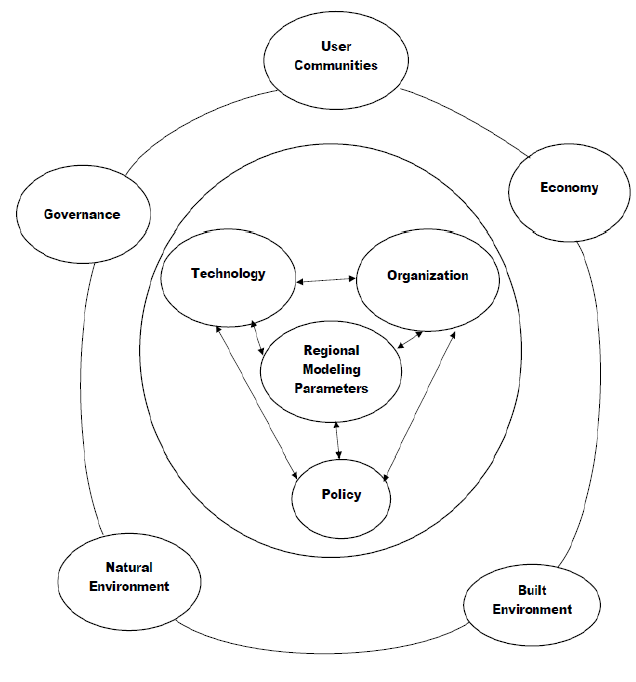
Figure 1. Shared Architecture of